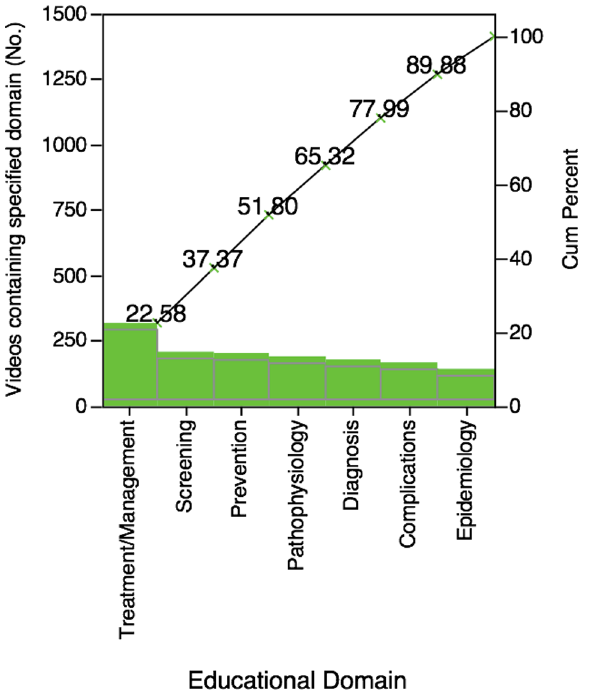
Figure 2. Pareto plot of educational domains present in YouTube videos.